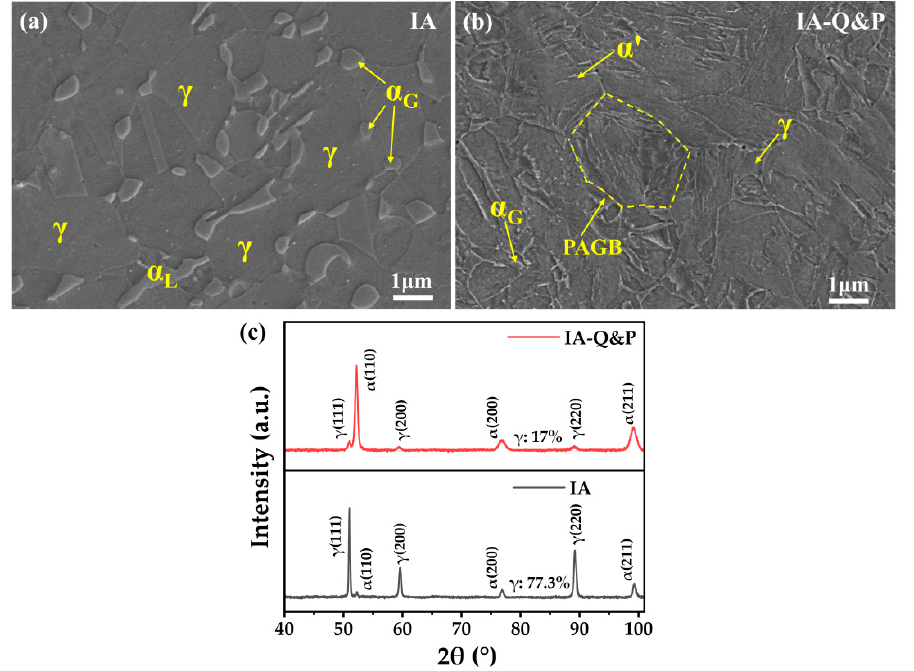
Figure 2. Initial microstructure in SEM ( a , b ) and XRD profiles ( c ) of IA steel and IA-Q&P steel. PAGB: prior austenite grain boundary; α L : lamellar ferrite; α G : granular ferrite; γ : austenite; α ’: martensite. XRD profiles showing.